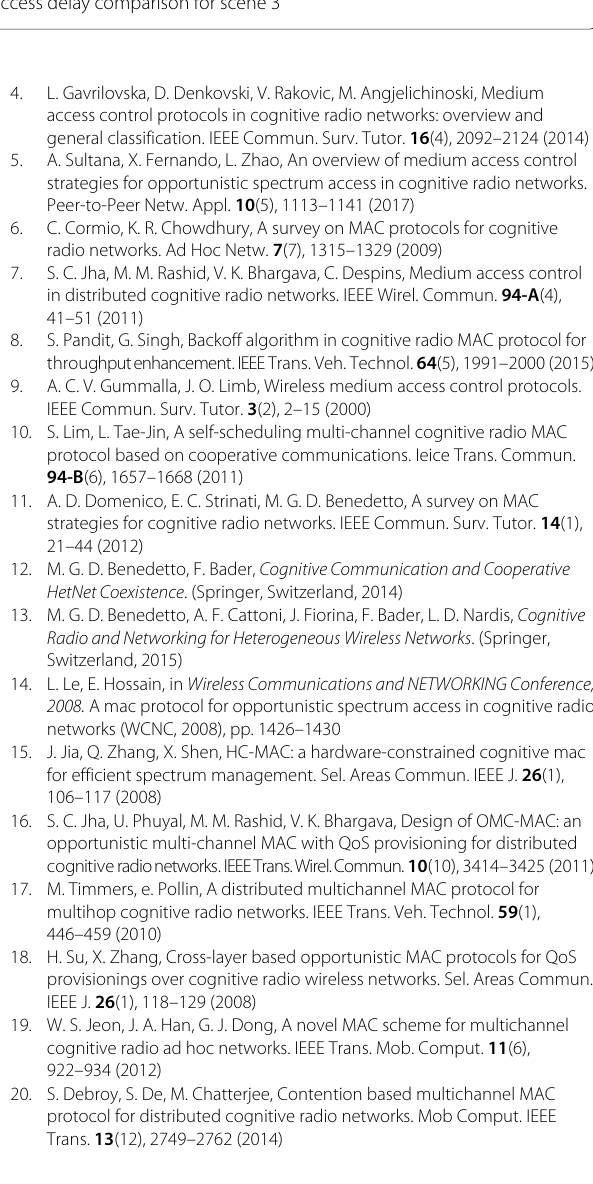
Fig. 15 Channel access delay comparison with M = 30, α = 0.1. Channel access delay comparison for scene 3